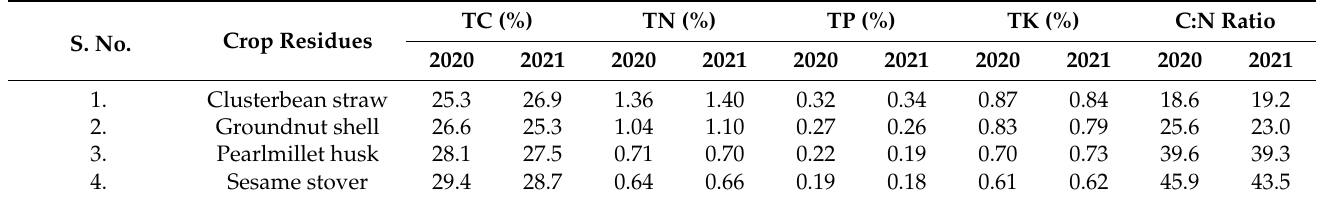
Table 1. Chemical composition of crop residues after 40 days of